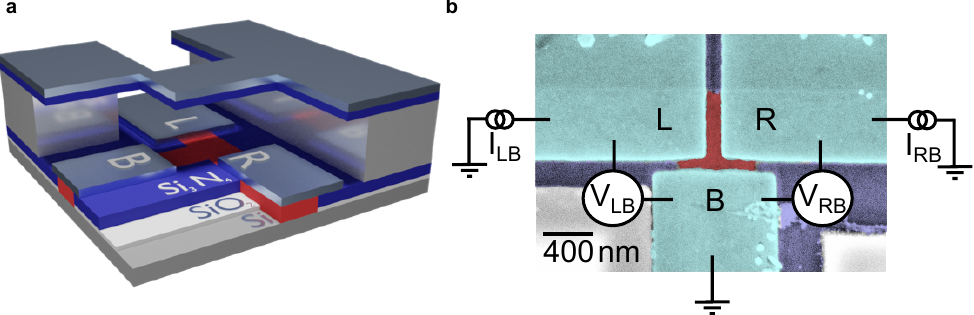
Figure 1. Rendering of a selective-area grown three-terminal Josephson junction and false color scanning electron micrograph with circuit: ( a ) The three-terminal junction is composed of the silicon substrate (gray bottom layer), the first hard mask composed out of a silicon oxide (white)/silicon nitride (blue) layer (as indicated by the labels). On top of this, another hard mask layer composed of silicon oxide (white) and silicon nitride (blue) is deposited and patterned as a shadow mask. The topological insulator (red) is grown selectively into the first hard mask trench and the shadow mask is used for the definition of the junction in the metal deposition (silver) step. ( b ) False-color scanning electron micrograph of the in situ prepared three-terminal junction device. Niobium contacts (cyan) are deposited on top of the TI (red). The measurement configuration is also